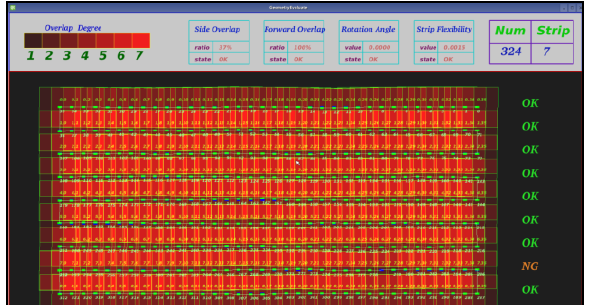
Figure 8. Result of real-time mosaicking